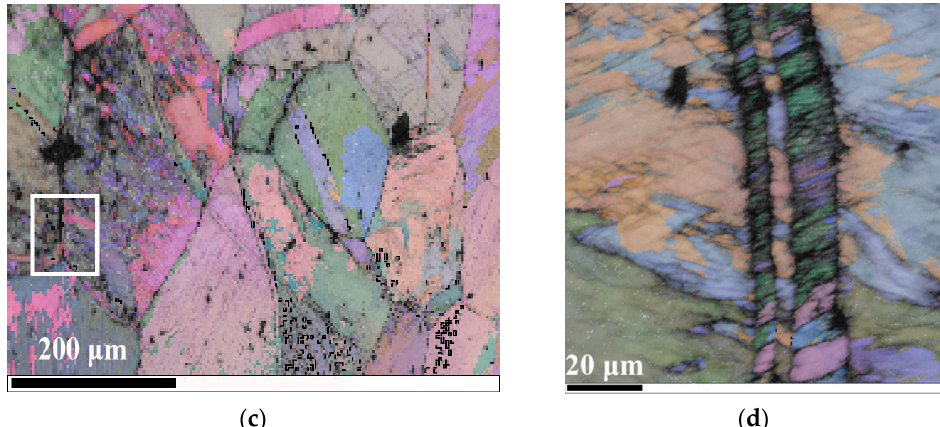
Figure 4. Electron backscattered diffraction images of the deformed NiCrFeCoMn HEA: ( a) Euler+Band Contrast (BC) image of the deformed sample at the strain rate 1250 s − 1 ; ( b ) image of the micro bands in ( a ); ( c ) Euler+BC image of the deformed specimen at the strain rate 2000 s − 1 ; ( d ) image of the twin band in ( c ).